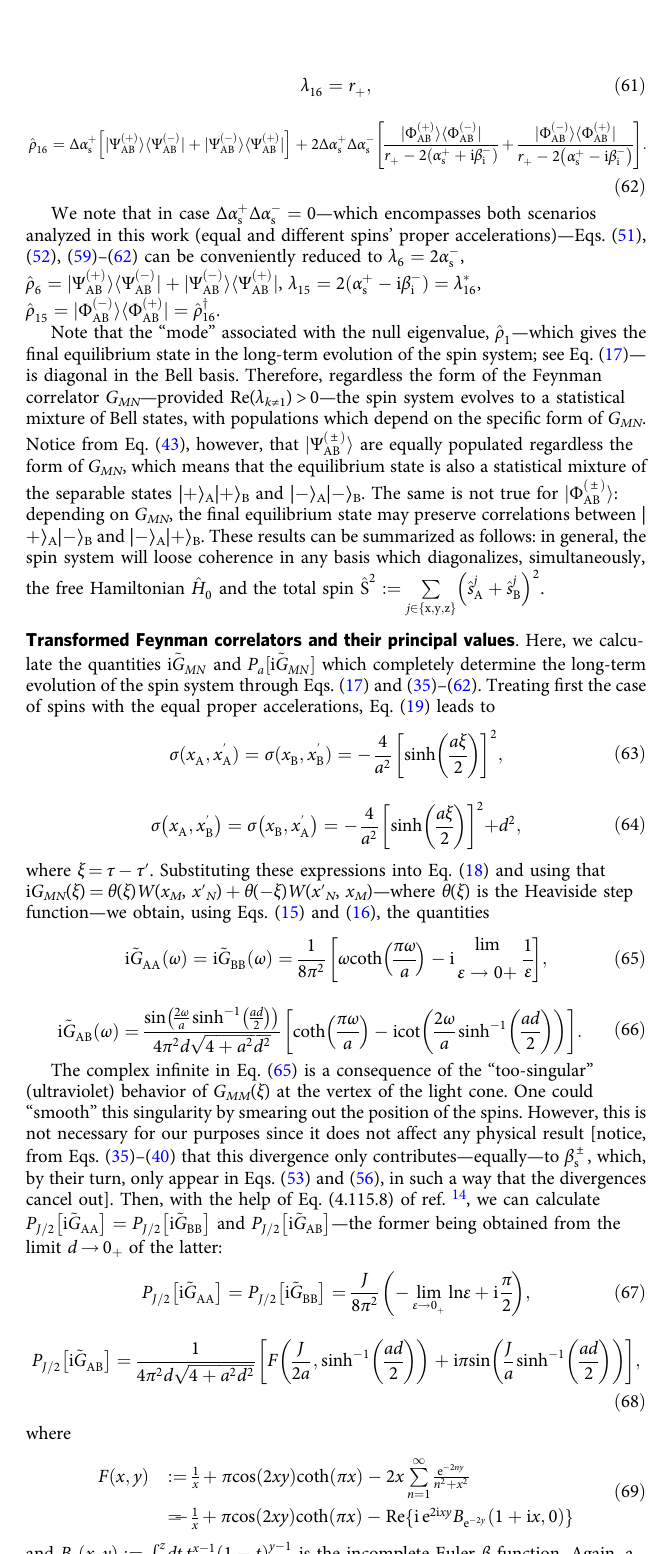
ffiffiffiffiffiffiffiffiffiffiffiffiffiffiffiffiffiffiffiffiffiffiffiffiffiffiffiffiffiffi ð α (cid:2) s Þ 2 þ 4 α þ i ð α þ i þ α (cid:2) i Þ